Question: Write a single sentence explaining what this figure depicts.
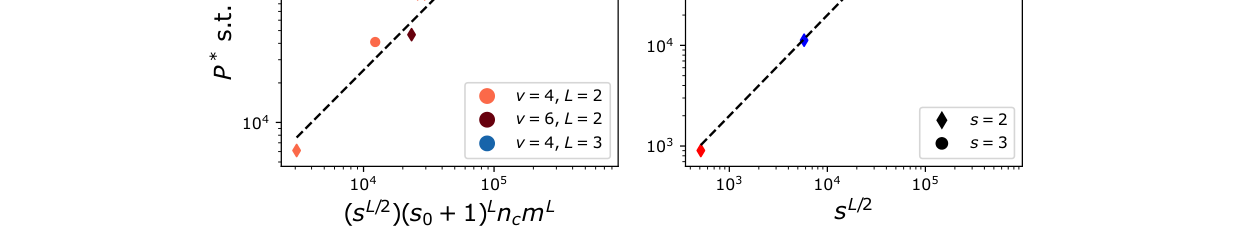
Answer: LCN: Left panel: empirical sample complexity P ∗to reach a 10% test error ε versus prediction Eq. 3 for s = 3, different vocabulary sizes v and different depths L (different colors), number of classes nc = v, maximal m = vs−1 and different s0 (different markers).Note an additional factor sL/2 in the prediction, further supported by the right panel, realised at fixed s0 = 1, nc = m = 4, and varying s and L.